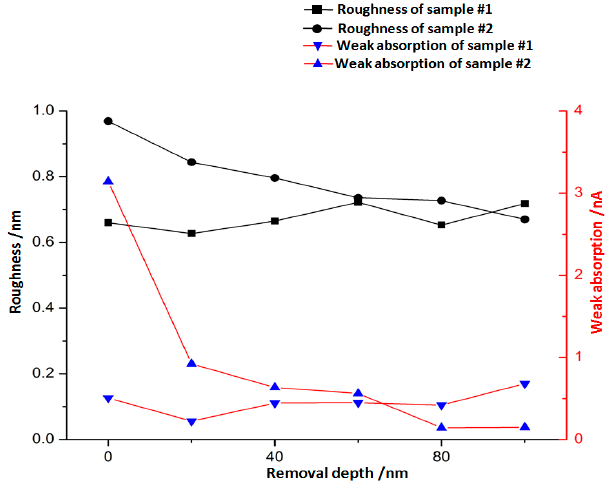
Figure 15. Surface revolution in EJP processing.